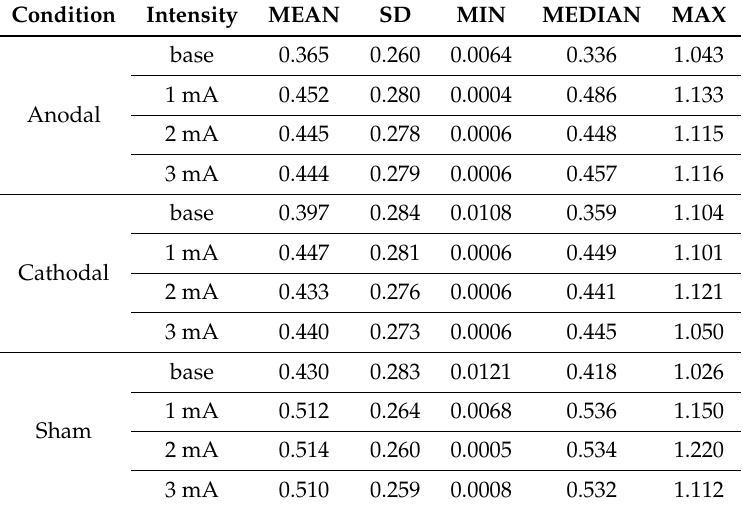
Table 1. ApEn summary among Stimulus versus Intensity.